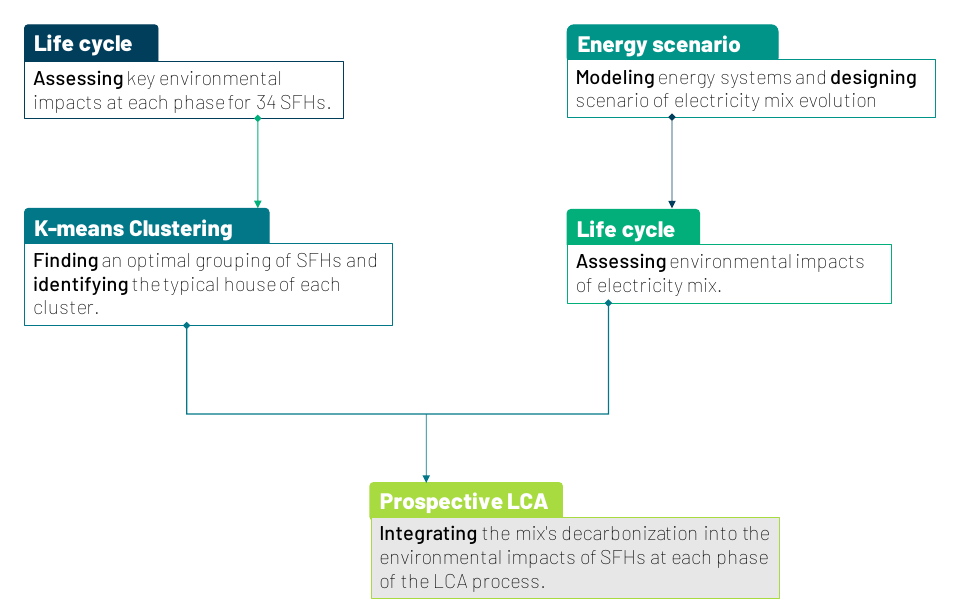
Figure 2. Synoptic of the overall